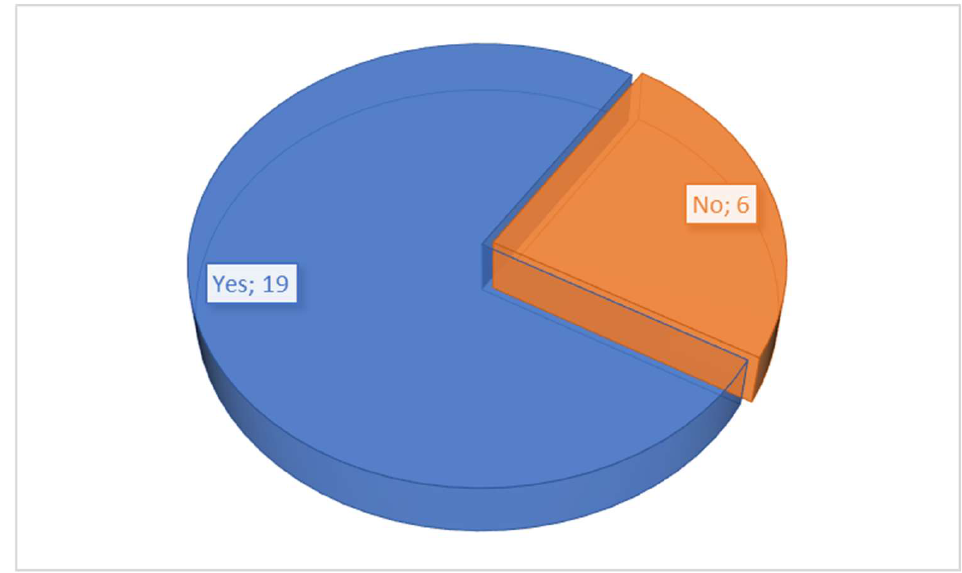
Figure 8. Analyzing innovations implemented by competitors.